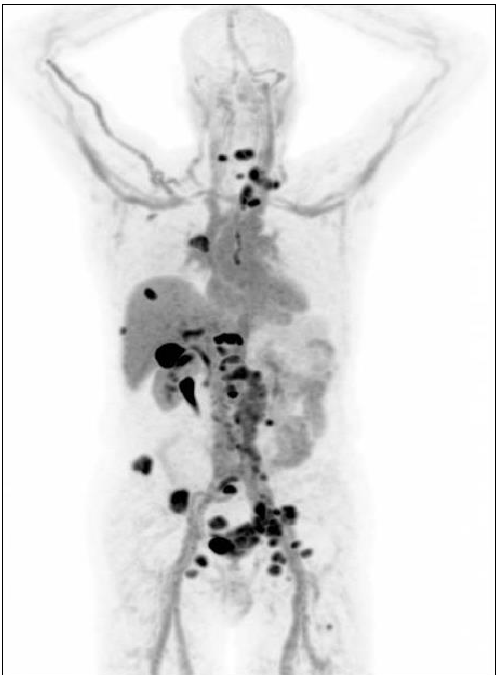
Figure 2. Example of [ 18 F]-FDHT-PET in a patient with metastasized prostate cancer: lymph node metastases in the neck, right hilus, retroperitoneal, para-iliacal and inguinal, bone metastases in the spine, ribs, pelvis and left femur.